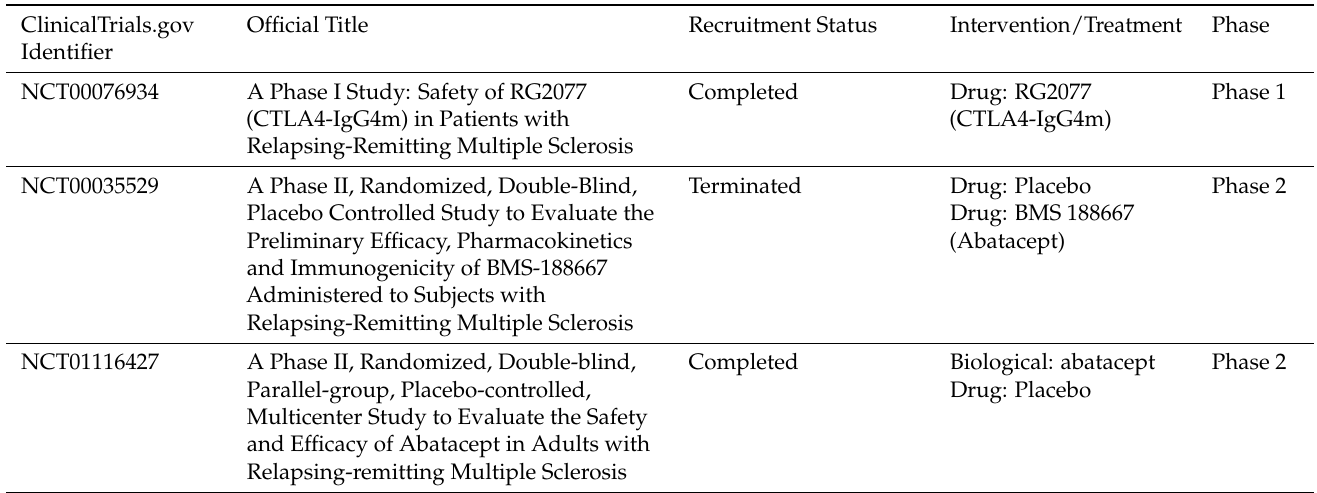
Table 5. Clinical trials investigating the possibility of using CTLA4-Ig in